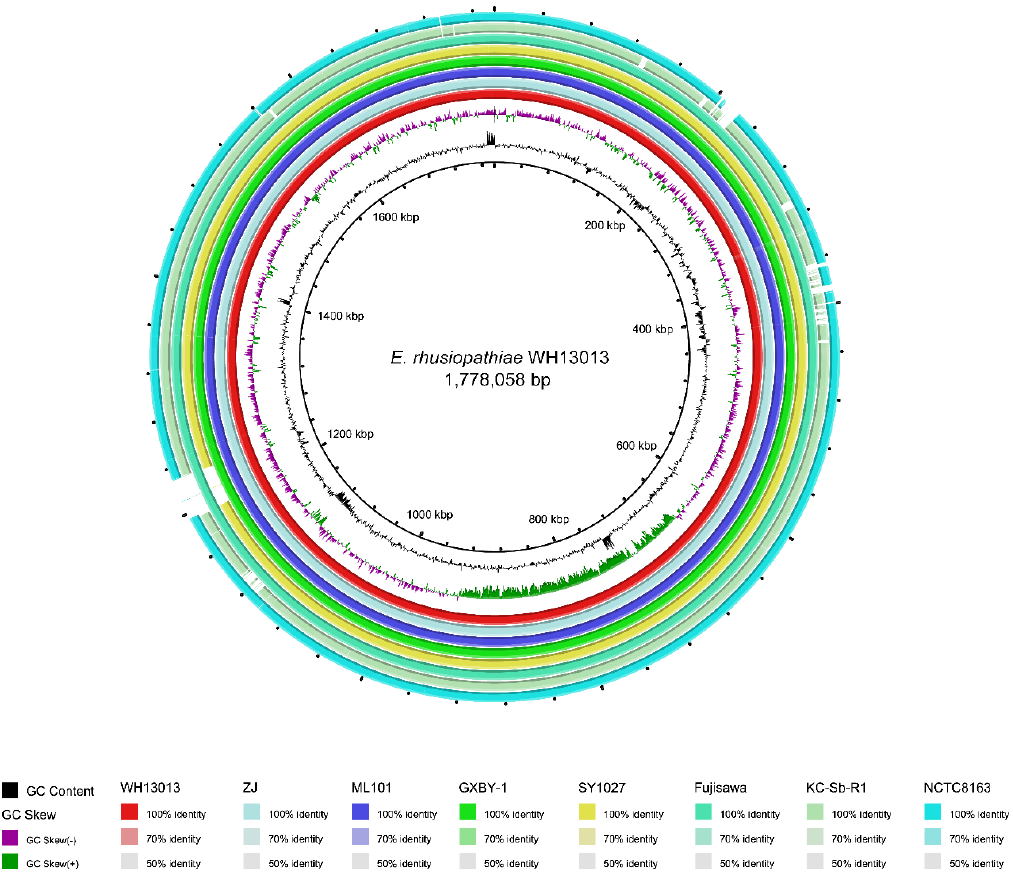
Figure 3 . Comparisons of genomes related to WH13013. Shown is a BRIG circular plot for BLASTN comparisons of WH13013 and related genomes. The first and second inner rings represent the GC content and GC skew of WH13013, respectively. From the third ring inside, each ring corresponds to a different genome, as follows, from inner to outer ring: WH13013, ZJ, ML101, GXBY-1, SY1027, Fujisawa, KC-Sb-R1, and NCTC8163.